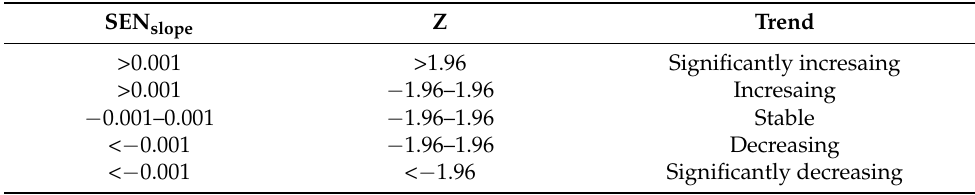
Table 2. Aboveground biomass change trend assessment table.